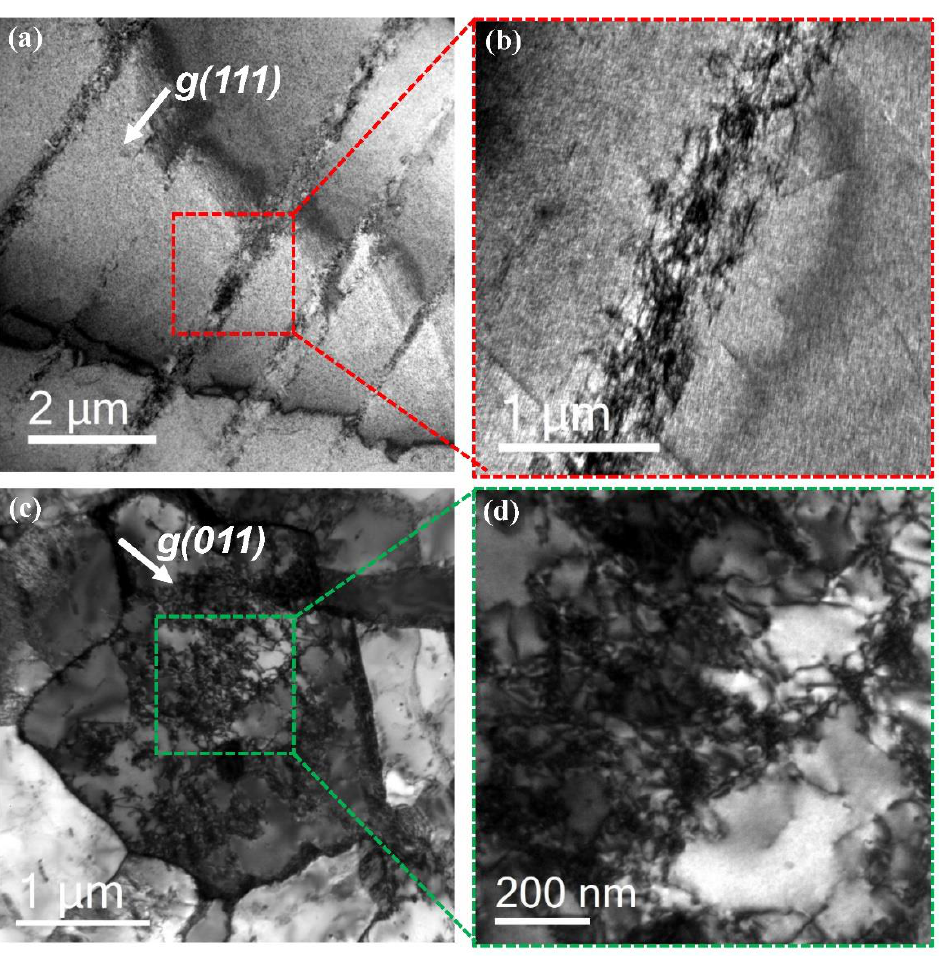
Figure 12. ( a , b ) Bright-field (BF) TEM images of the deformed lightweight steel and ( c , d ) BF TEM images of the deformed 12% Cr